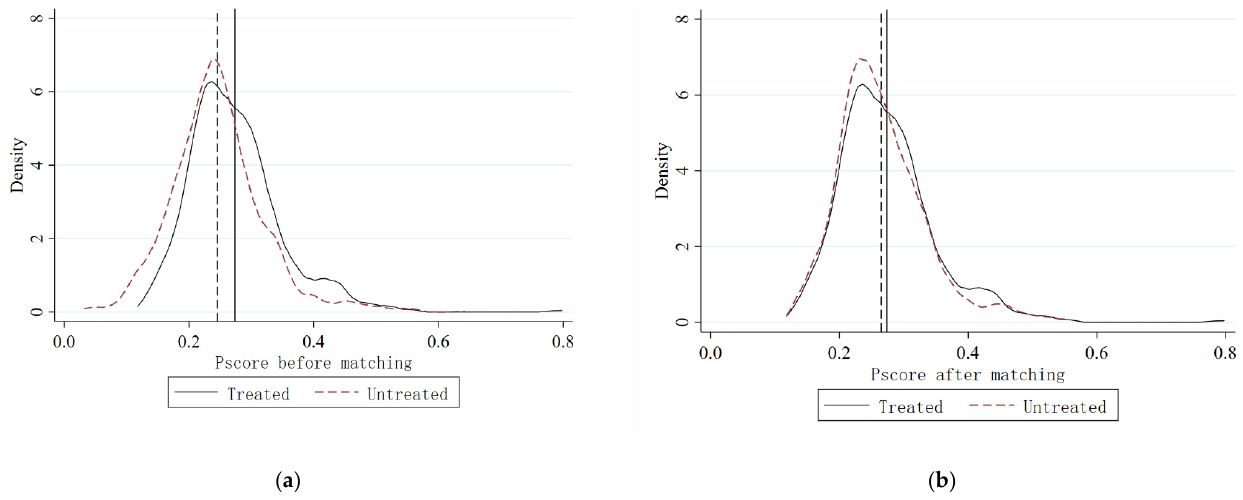
Figure 5. The P-score kernel density. ( a ) P-score before matching. ( b ) P-score after matching.